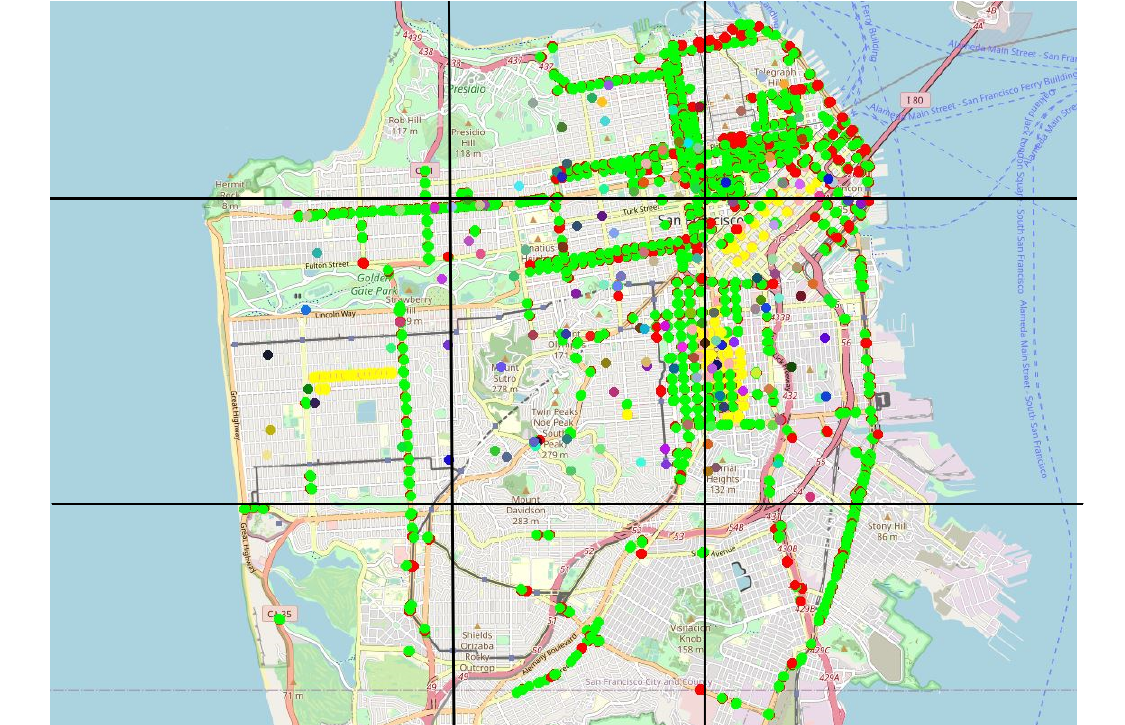
Figure 17. Capture of San Francisco from Sim2Car with proposed region